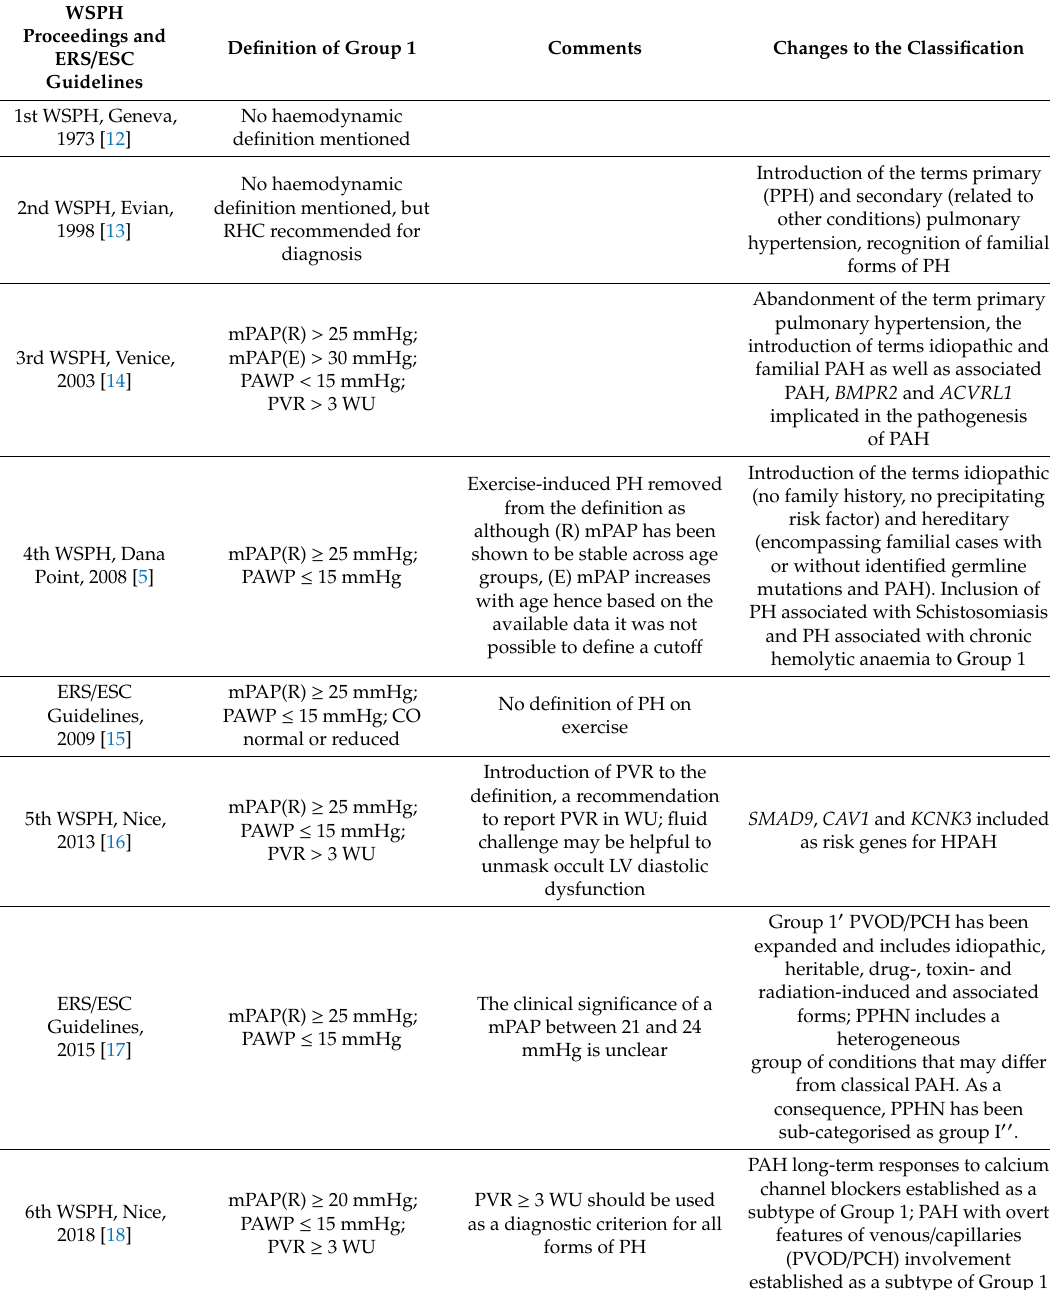
Table 1. Definitions and changes to the classification of Group 1 PAH. Abbreviations: WSPH—World Symposium on Pulmonary Hypertension; ERS / ESC—European Respiratory Society and European Society of Cardiology; mPAP—mean pulmonary artery pressure; (R)—resting; (E)—exercise; PAWP—pulmonary artery wedge pressure; PVR—pulmonary vascular resistance; LV—left ventricle; PPH—primary pulmonary hypertension; BMPR2 —Bone morphogenetic protein receptor, type II; ACVRL1 —Activin A receptor like type 1; SMAD9 —SMAD Family Member 9; CAV1 —Caveolin 1; KCNK3 —Potassium two pore domain channel subfamily K member 3; PVOD / PCH—pulmonary veno-occlusive disease / pulmonary capillary haemangiomatosis; PAH—pulmonary arterial hypertension; PH—pulmonary hypertension; PPHN—persistent pulmonary hypertension of the newborn; RHC—right heart